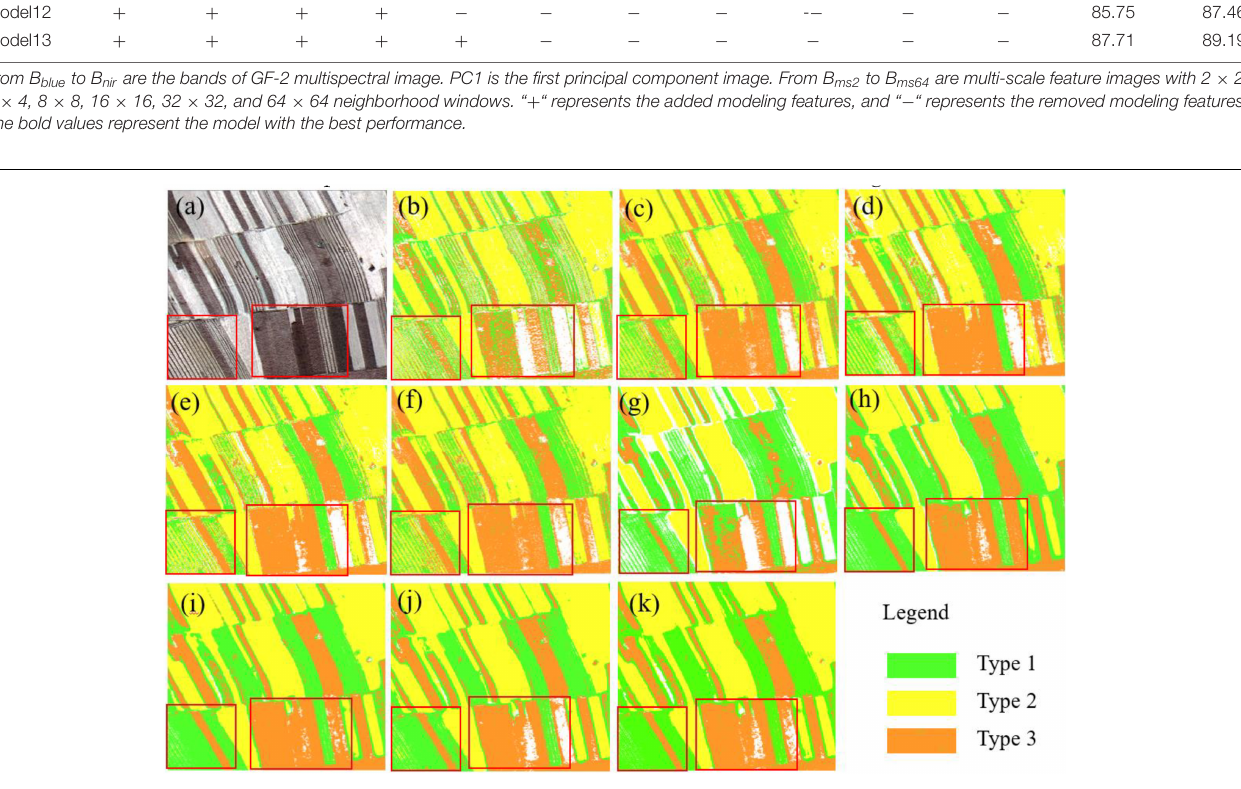
FIGURE 9 | Visualization of the classification result for different machine learning methods in sub-images. The original sub-image is (a) (R/B red , G/B green , and B/B blue ). (b–f) correspond to the classification results of NB, RF, SVM, 1D-CNN, and 1D-CNN_CA methods, respectively, using the image dataset DT1 (B blue , B green , B red , and B nir ). (g–k) correspond to the classification results of NB, RF, SVM, 1D-CNN, and 1D-CNN_CA, respectively, using OID (B blue , B green , B red , B nir , B ms4 , B ms8 , B ms16 , B ms32 , and B ms64 ).